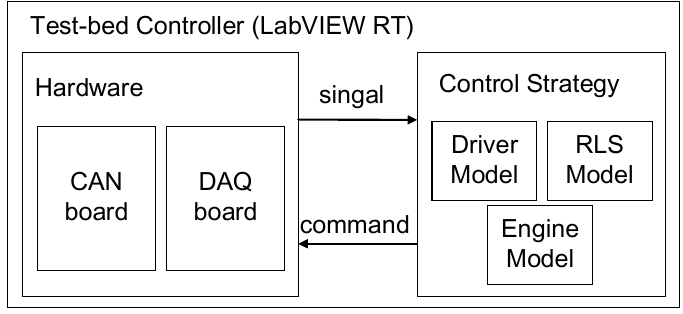
Figure 2. Structure of test-bed controller.